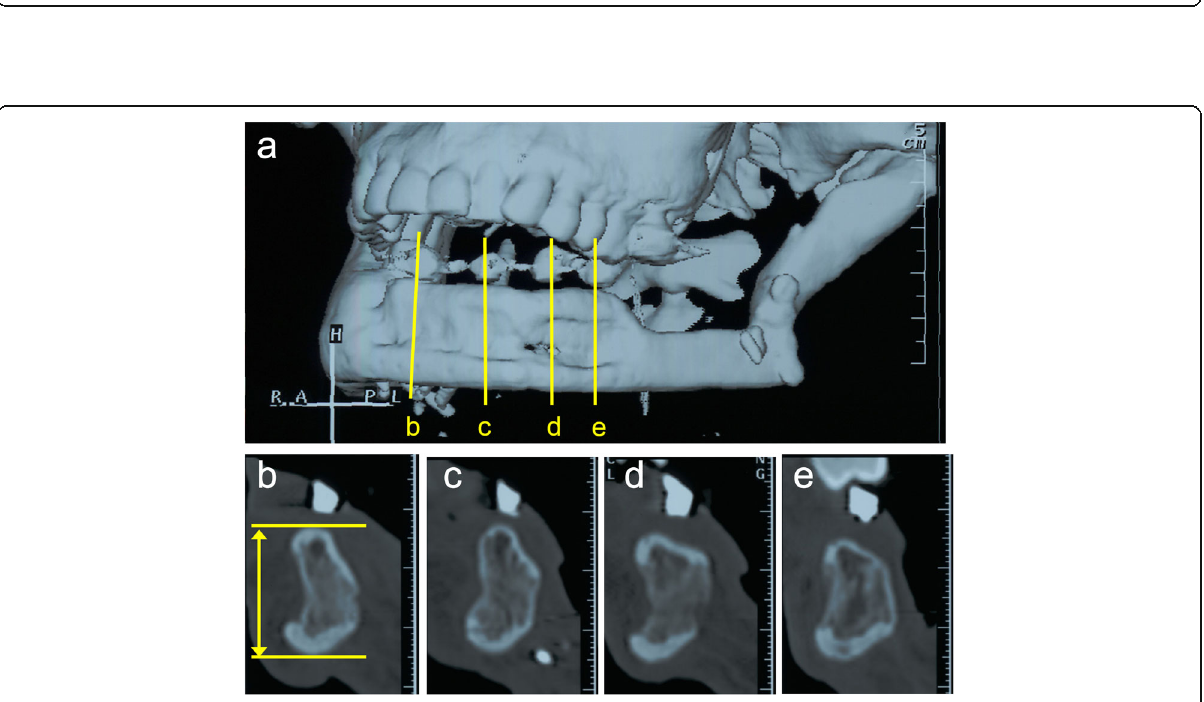
Fig. 4 a , b Two distractors were fixed at the planned position. Orthopantomogram c 1 day postoperatively and d at the end of distraction